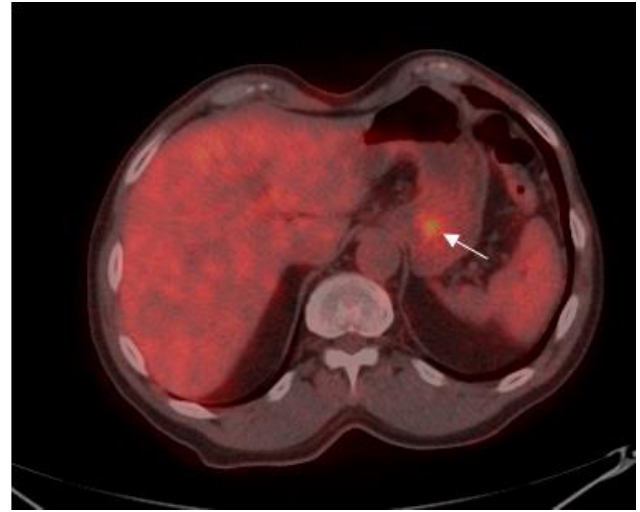
was not significant (92.5% vs. 81.0%; p = 0.10).